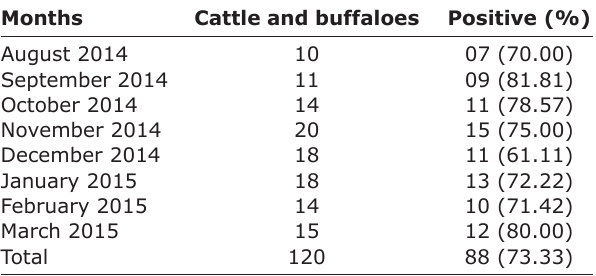
Table-3: Month wise prevalence of GI parasites in cattle and buffaloes.